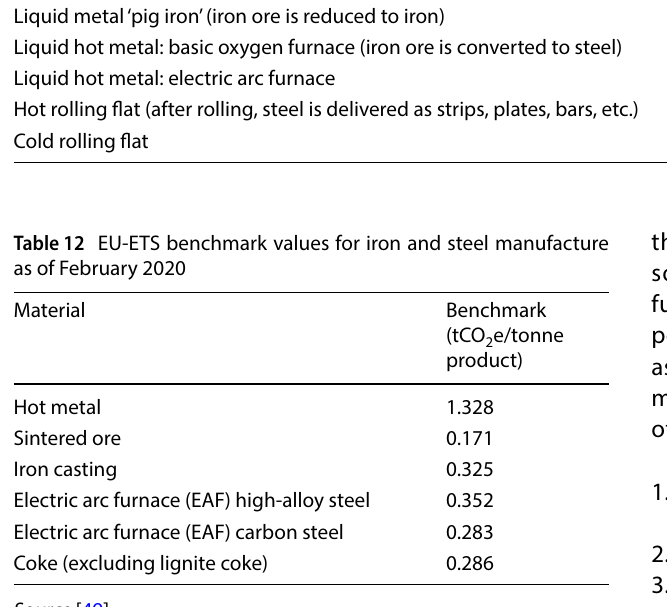
Table 11 Steel production—main processes and energy requirements Process